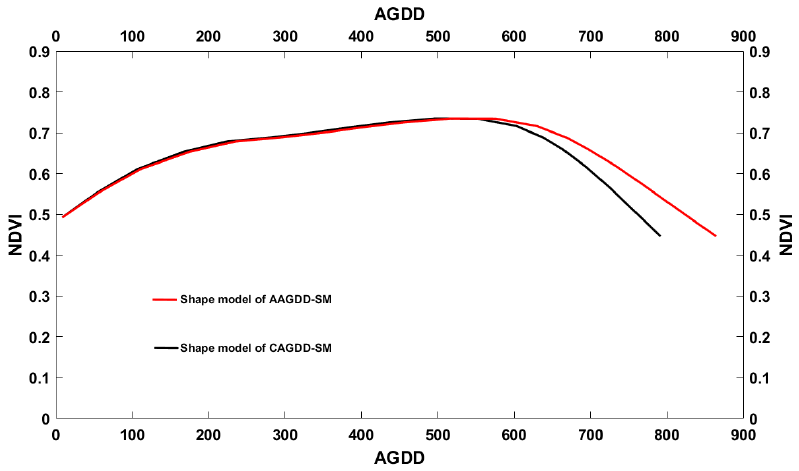
Figure 5. Shape models of AAGDD ‐ SM and CAGDD ‐ SM .